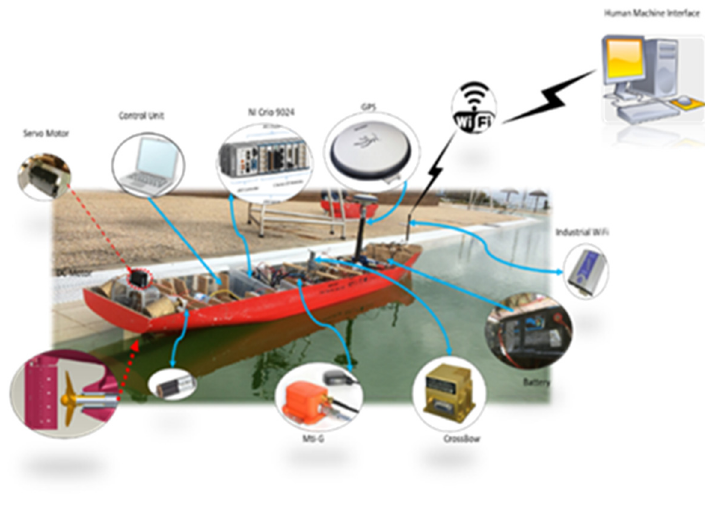
Figure 2. Sensors and actuators installed on the ship model.